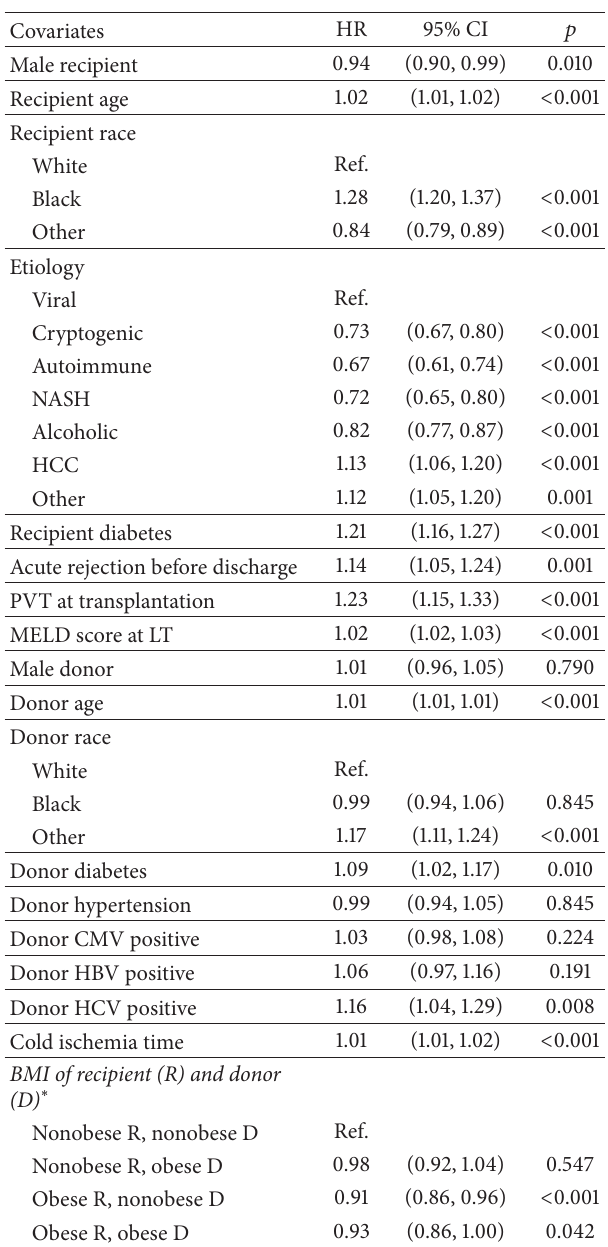
Table 2: Multivariable Cox proportional hazards regression of survival after liver transplantation ( 𝑛 =